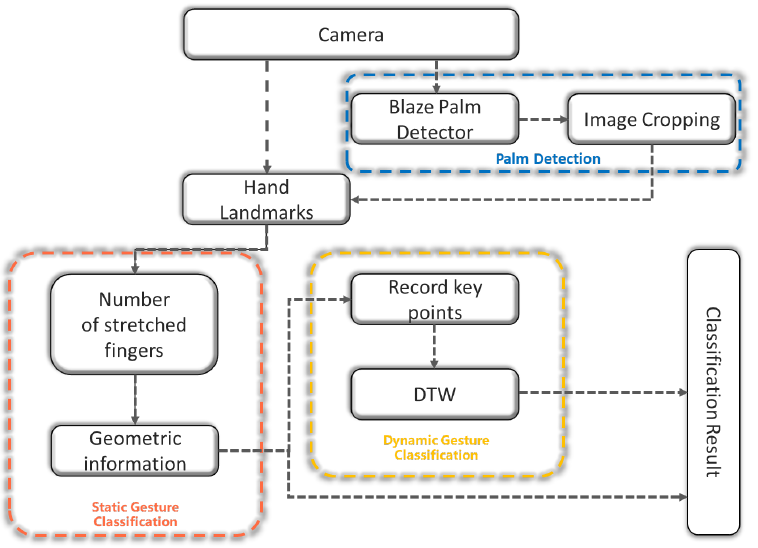
Figure 4. Gesture recognition framework. The Palm Detection module is only used when the first frame of the input camera image and the first palm appears in the image